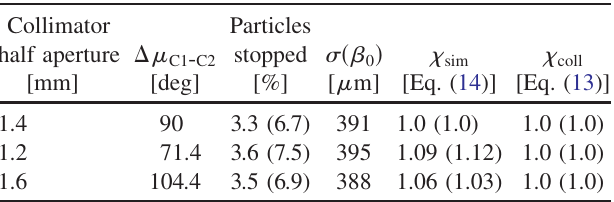
TABLE IV. Comparison of the simulated and the analytical collimation performance for C1-C2 phase advance as prescribed by Table II and different collimator half apertures. The numbers in parentheses refer to the 2D collimation performed with rectangular jaws; in this case, the 2D collimation index is calculated as the product of the two 1D ones.